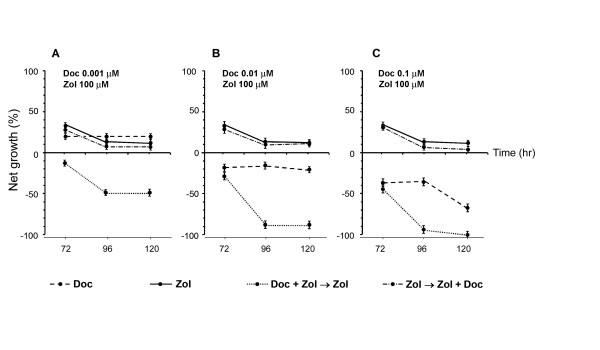
Comparison between different drug schedules. Dashed line: activity observed 72, 96 and 120 h after a 1-h exposure to low Doc concentrations (0.001, 0.01 and 0.1 μM in diagrams A, B and C, respectively). Solid line: activity detected after a 72-, 96- and 120-h continuous exposure to Zol 100 μM. Dotted line: activity observed after a 1-h concomitant exposure to Zol 100 μM and low Doc concentrations (0.001, 0.01 and 0.1 μM, in diagrams A, B and C, respectively) followed by prolonged exposure to Zol 100 μM. Dash-dotted line: activity observed after prolonged exposure to Zol 100 μM followed by a 1-h concomitant exposure to Zol 100 μM and low Doc concentrations (0.001, 0.01 and 0.1 μM, in diagrams A, B and C, respectively). Error bars represent the mean standard deviation.